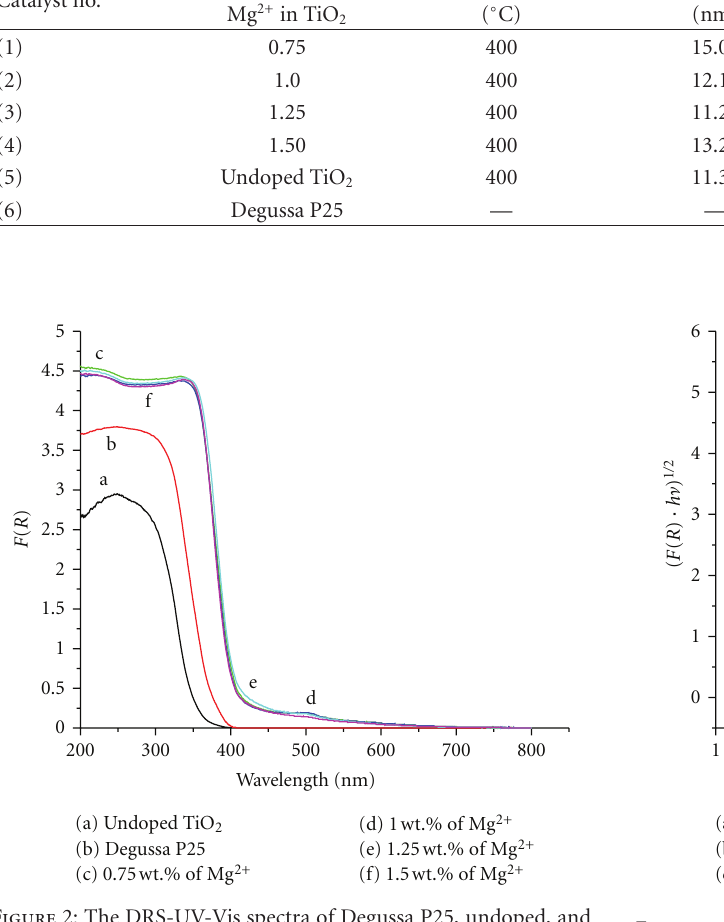
Figure 3: Plots of transformed Kubelka-Munk functions [ F ( R ) ··· hv] 1 / 2 versus h v for Degussa P25, undoped TiO 2 , and Mg 2+ -doped TiO 2